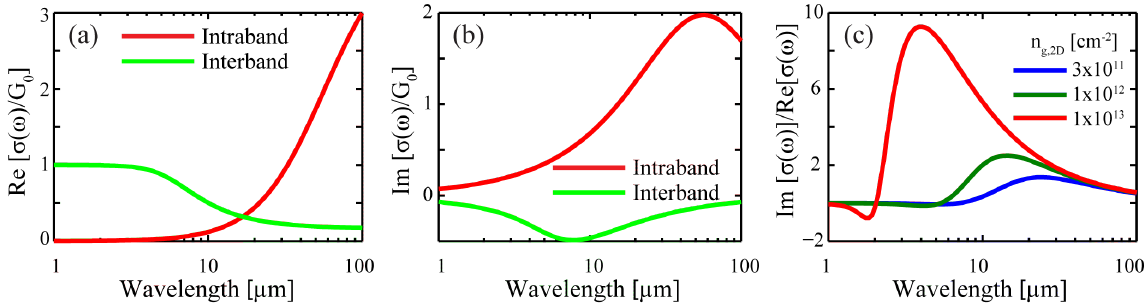
Figure 2: Relative contributions of interband and intraband transitions to real part (a) and imaginary part (b) of conductivity. Interband con- ductivity is dominant at visible frequencies while intraband contribution dominates above mid-infrared frequencies (n g ,2 D = 7 × 10 11 cm −2 , T = 300 K, τ = 3 × 10 −14 s ) ; (c) Figure of merit calculations indicating that graphene is a good plasmonic material between 2 µm–20 µm wavelengths. The plasmonic response can be tuned to near-infrared wavelengths by increasing carrier density in graphene.